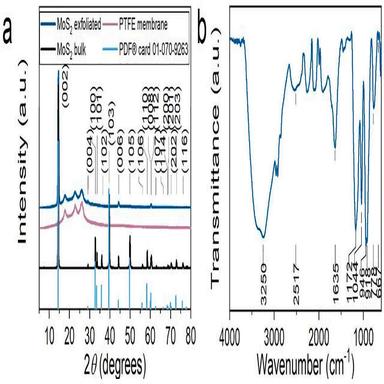
(a) X-ray diffractograms of MoS2 in the bulk and exfoliated forms, of the PTFE membrane used as the substrate for the exfoliated MoS2 and the molybdenite 2H PDF® card 01–070-9263 pattern. (b) FTIR spectrum of MoS2.